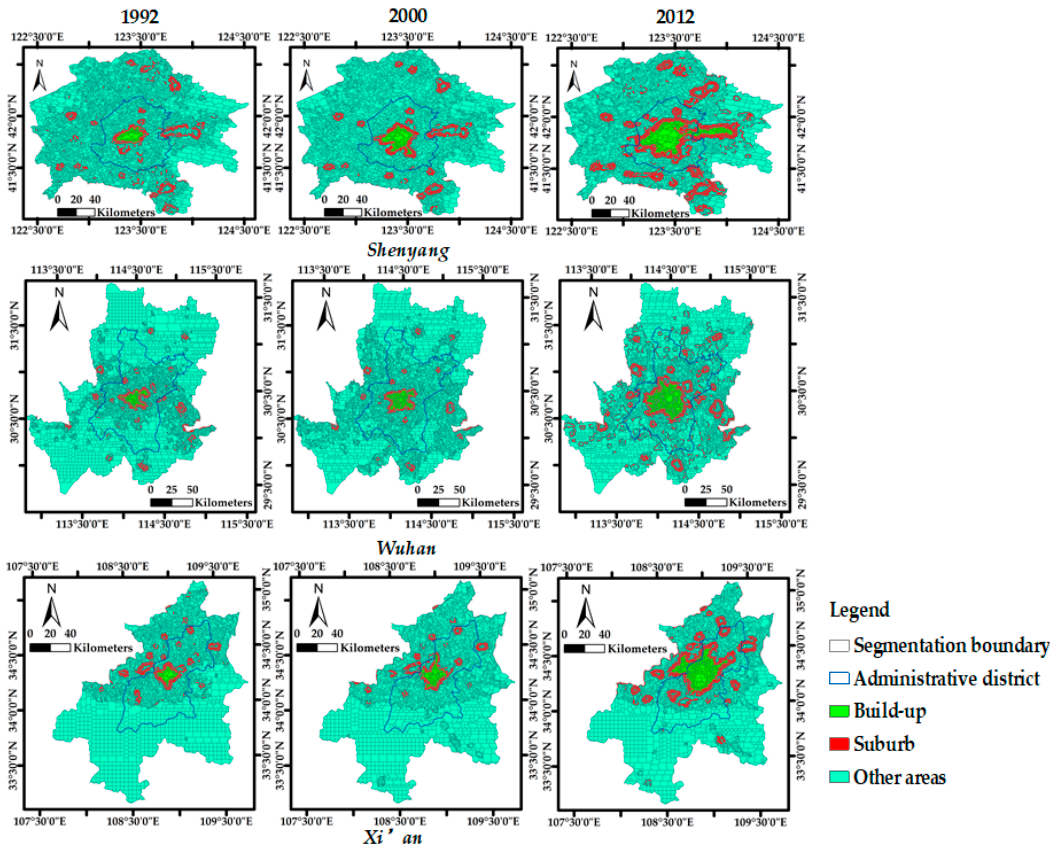
Figure 4. Suburban classification results.